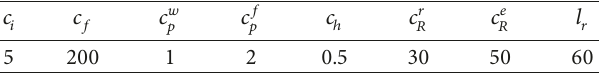
Table 5: Initial parameters.